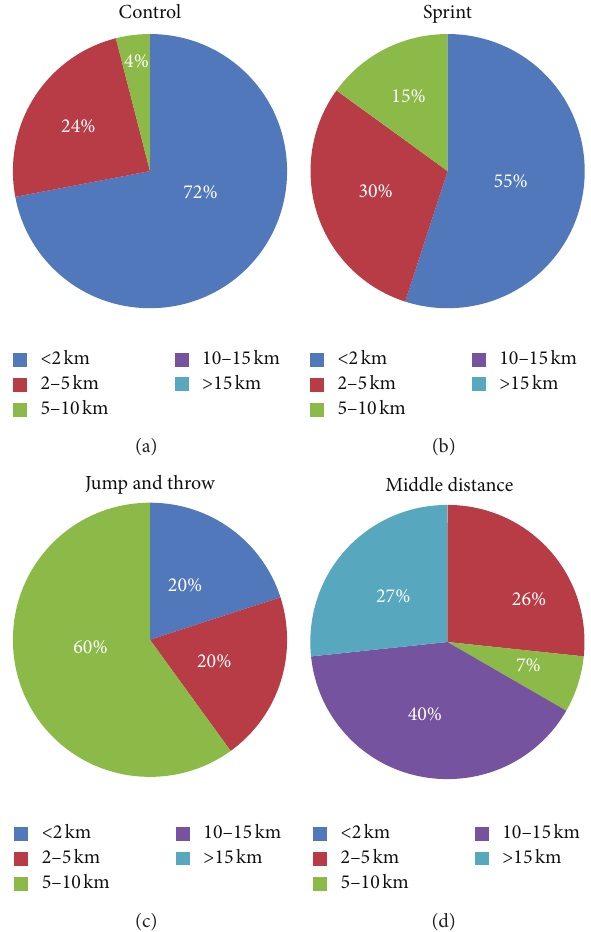
Figure 3: Distances travelled to school. Charts showing percentage of participants and distances traveled to school daily. The jump and throw and middle distance athletes differed significantly from the sprint athletes and